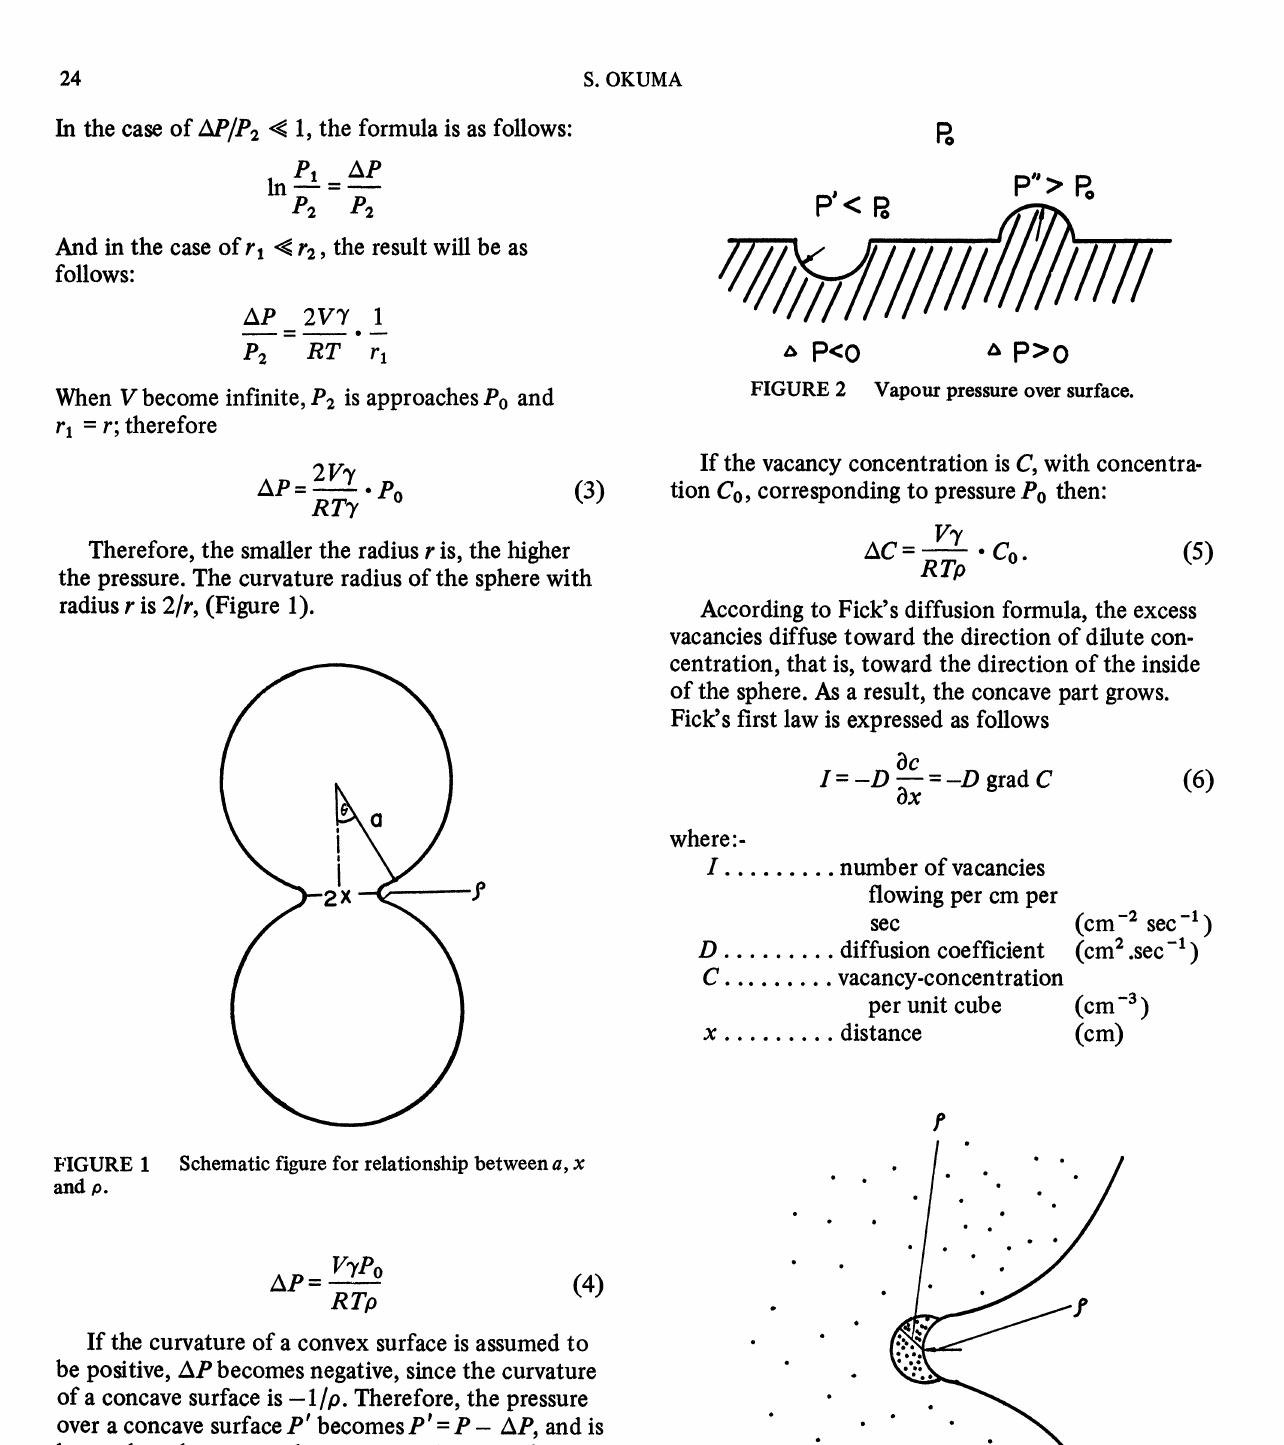
Distribution of